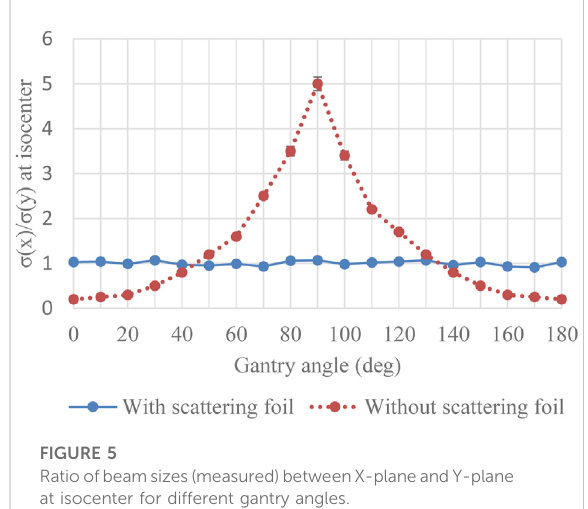
FIGURE 5 Ratioofbeamsizes(measured)betweenX-planeandY-plane at isocenter for different gantry